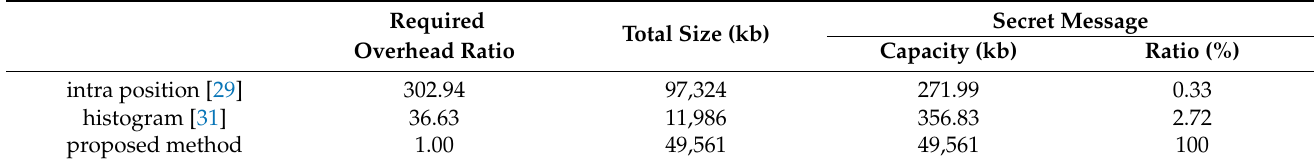
Table 5. Comparison of required cover video sizes with the same secret video